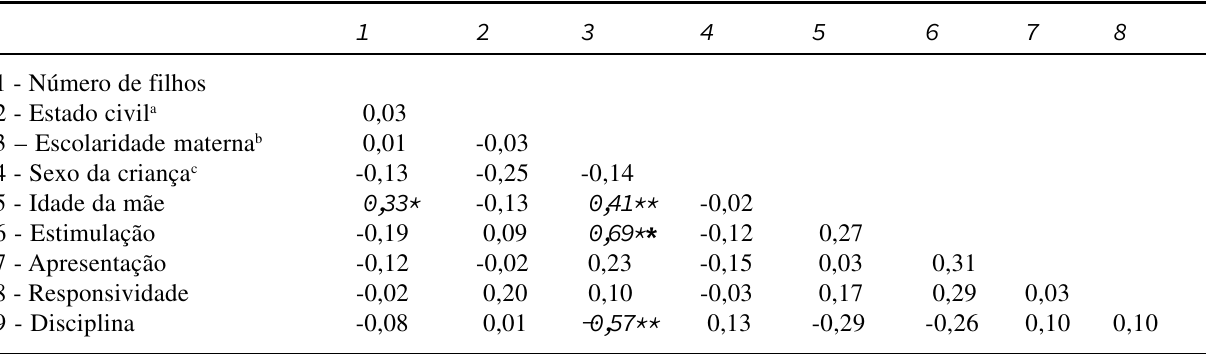
fator. No fator Disciplina, as diferenças significativas fo- ram entre as mães da ZR e ZUES, e também entre as mães da ZUBE e ZUES. As mães da ZUBE obtiveram o maior escore de respostas neste fator, seguidas pelas mães da